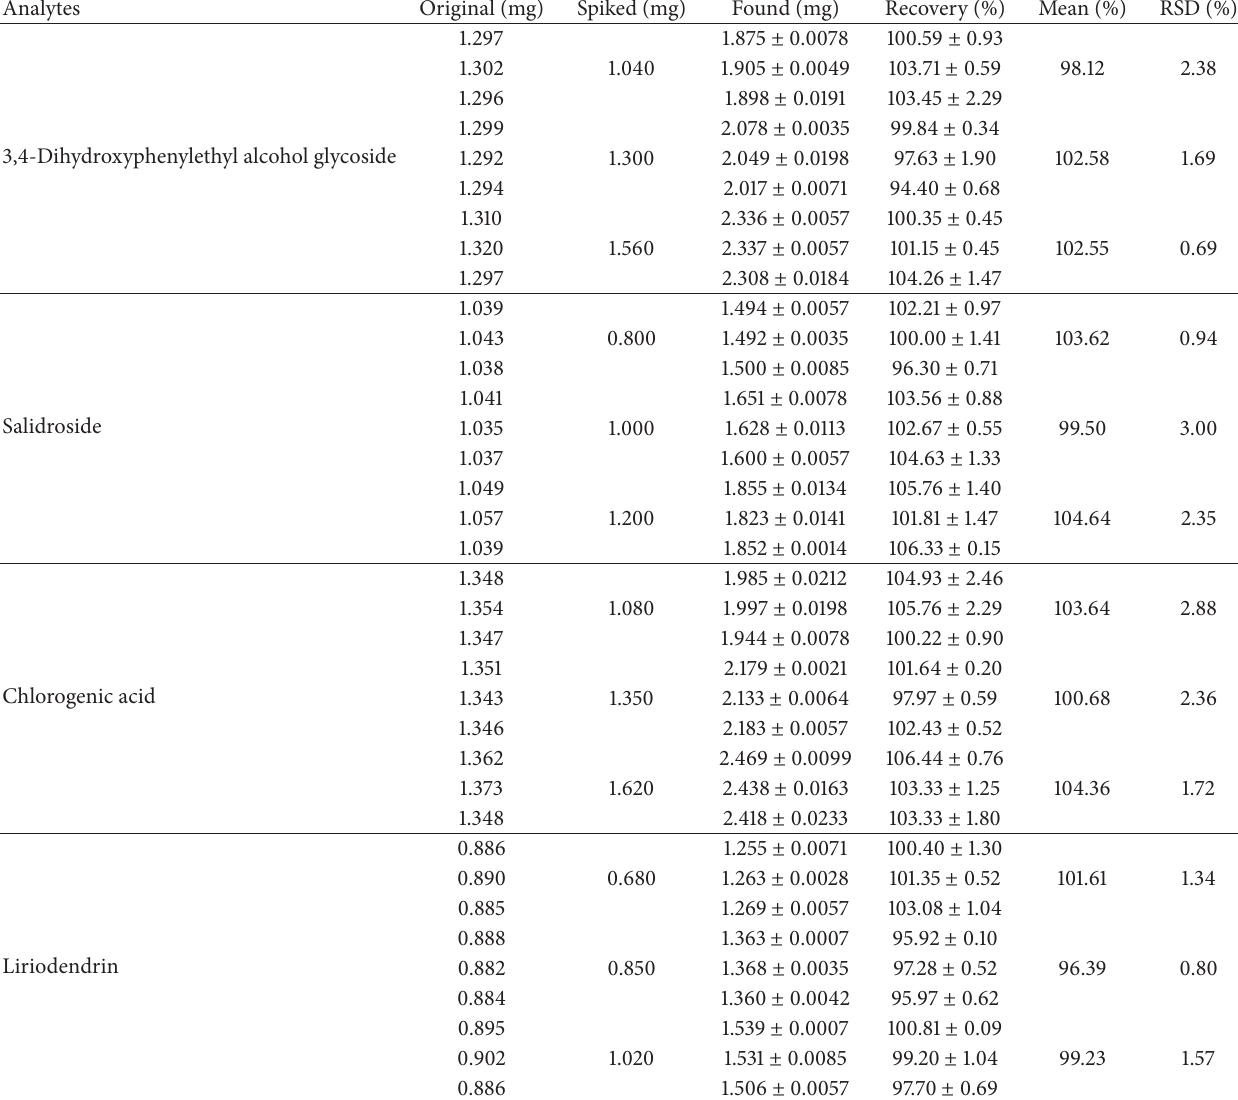
Table 2: Recoveries of spiked analytes.